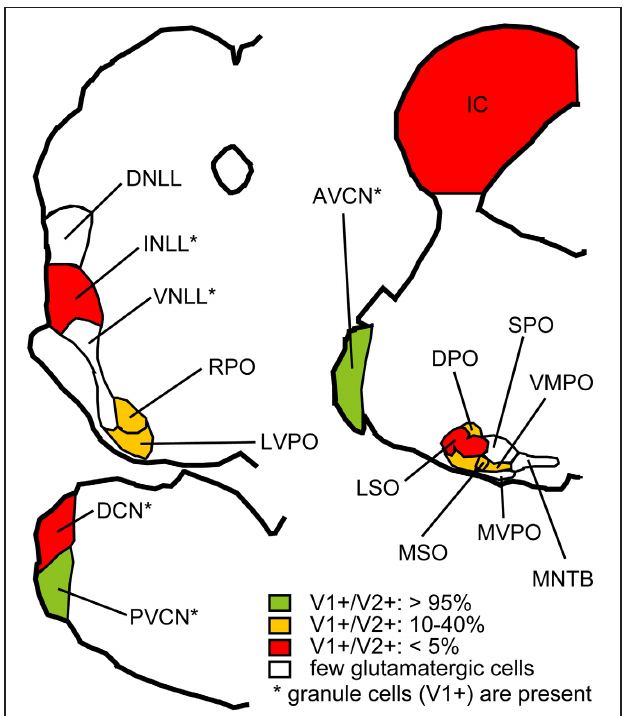
FIGURE 3 | Summary of VGLUT mRNA expression in the rat auditory brainstem. Red: Nuclei where less than 5% of glutamatergic neurons express both VGLUT1 and VGLUT2 and other glutamatergic neurons express VGLUT2 only. Green: Nuclei where more than 95% of glutamatergic neurons express both VGLUT1 and VGLUT2. Orange: Nuclei where 10–40% of glutamatergic neurons express both VGLUT1 and VGLUT2, and other glutamatergic neurons express VGLUT2 only. White: Nuclei with almost no glutamatergic neurons. Note that granule cells, expressing VGLUT1 only, are found in nuclei with asterisks, and excluded from analysis. Abbreviations: DNLL, dorsal nucleus of the lateral lemniscus; AVCN, anteroventral cochlear nucleus; PVCN, posteroventral cochlear nucleus; MVPO, medioventral periolivary nucleus; SPO, superior paraolivary nucleus; MNTB, medeial nucleus of the trapezoid body. For other abbreviations, see text. Modified from Ito et al.